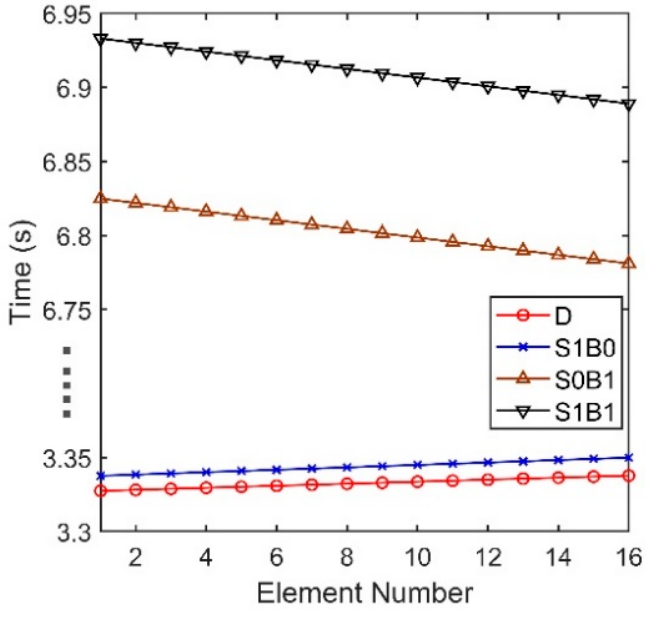
Figure 3. Arrival times of D, S1B0, S0B1 and S1B1.